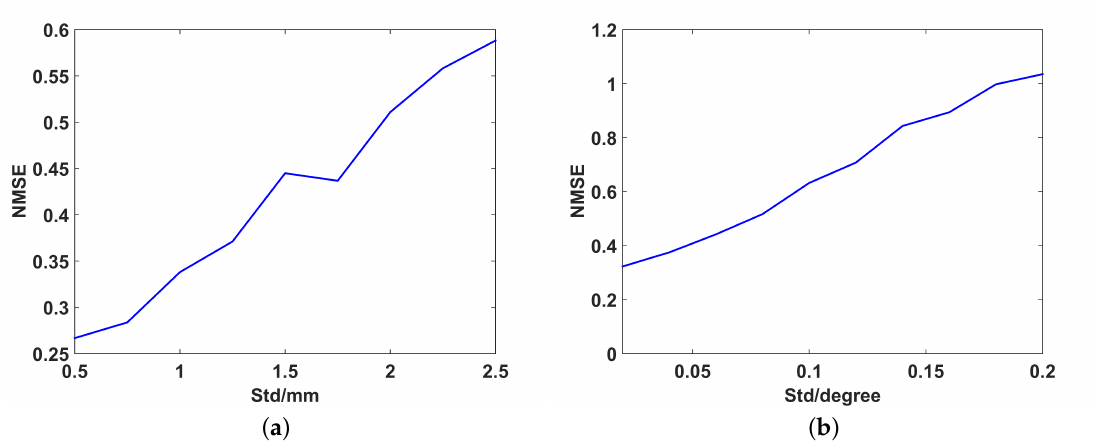
Figure 17. The NMSE of imaging result under different measuring accuracy. ( a ) position-measuring accuracy; ( b ) angular-measuring